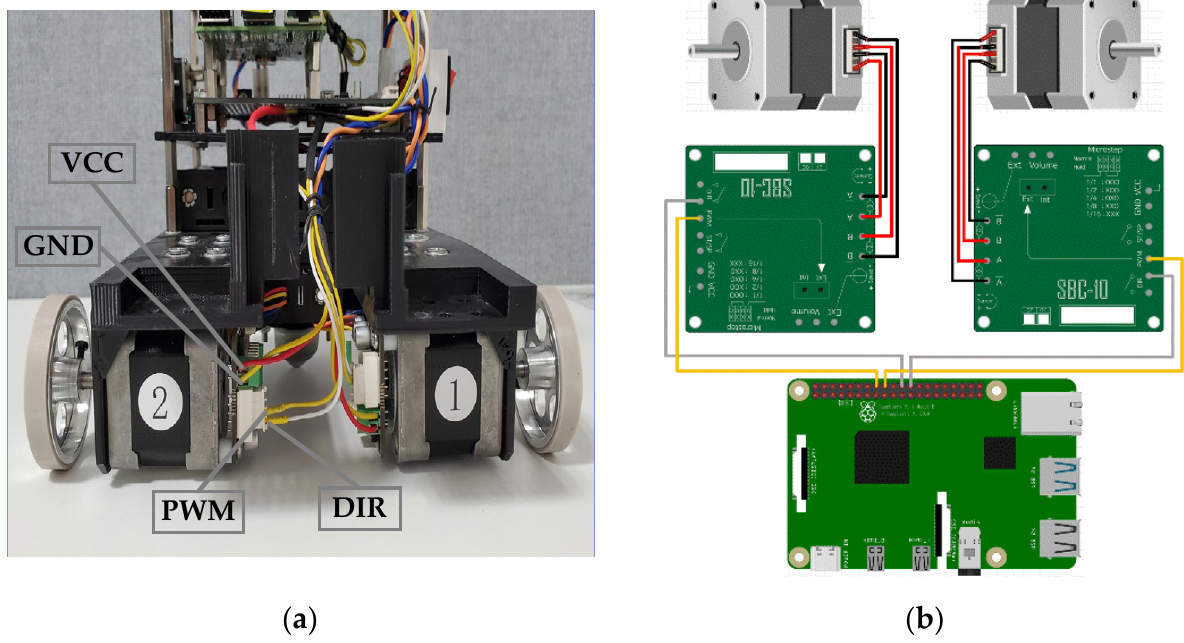
Figure 2. Motor connections of Owlbot. ( a ) Installation diagram; ( b ) Connection between the stepping motor, SBC-10 controller, and Raspberry Pi 4B.